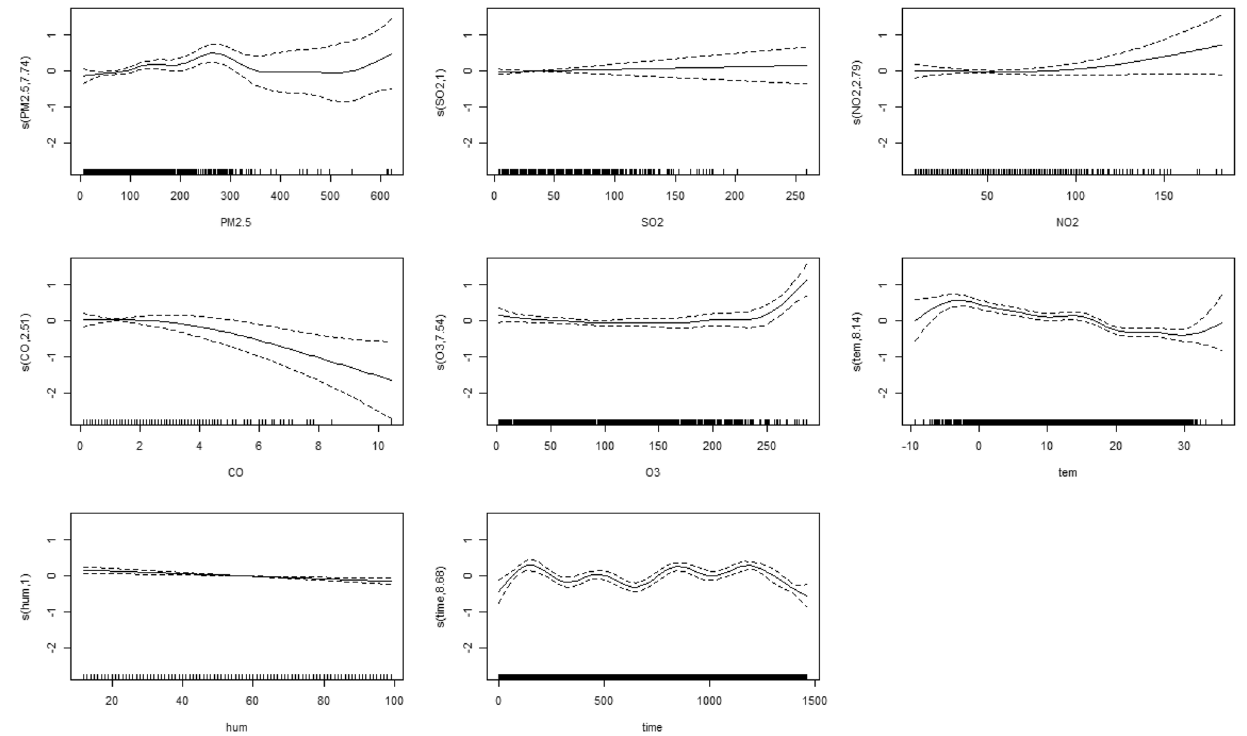
Figure 3. Relationship between air pollutants, meteorological variables and AECOPD cases ( tem , temperature, hum relative humidity). Y-axis: the predicted value of AECOPD cases as the independent variables changed. X-axis: the distribution of variables (including PM 2.5 , other air pollutants, temperature, humidity and time) in the AECOPD